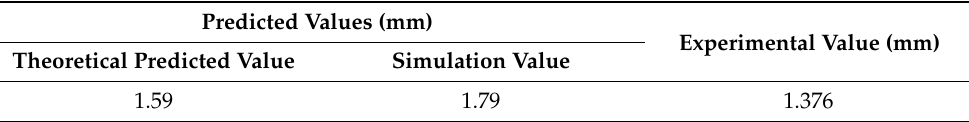
Table 5. Comparison between the measured and predicted deflection values under 1kN static load at the center of the T1 floor.